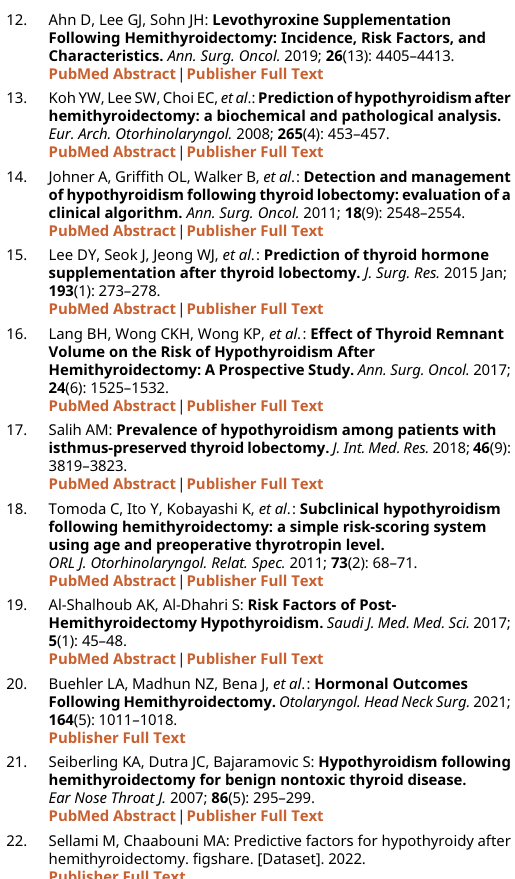
Figshare: Predictive factors for hypothyroidy after hemithyroidectomy, https://doi.org/10.6084/m9.figshare.21404862. v1.